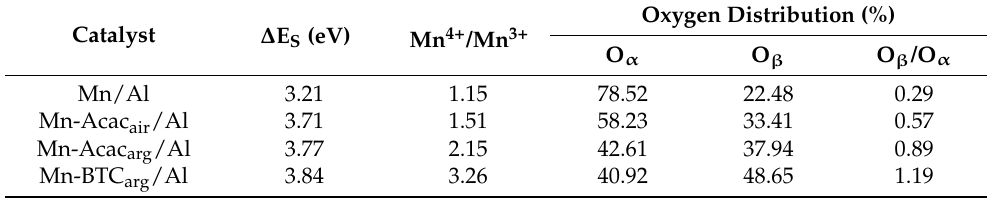
Table 2. The summary of XPS analysis results for the prepared catalysts.